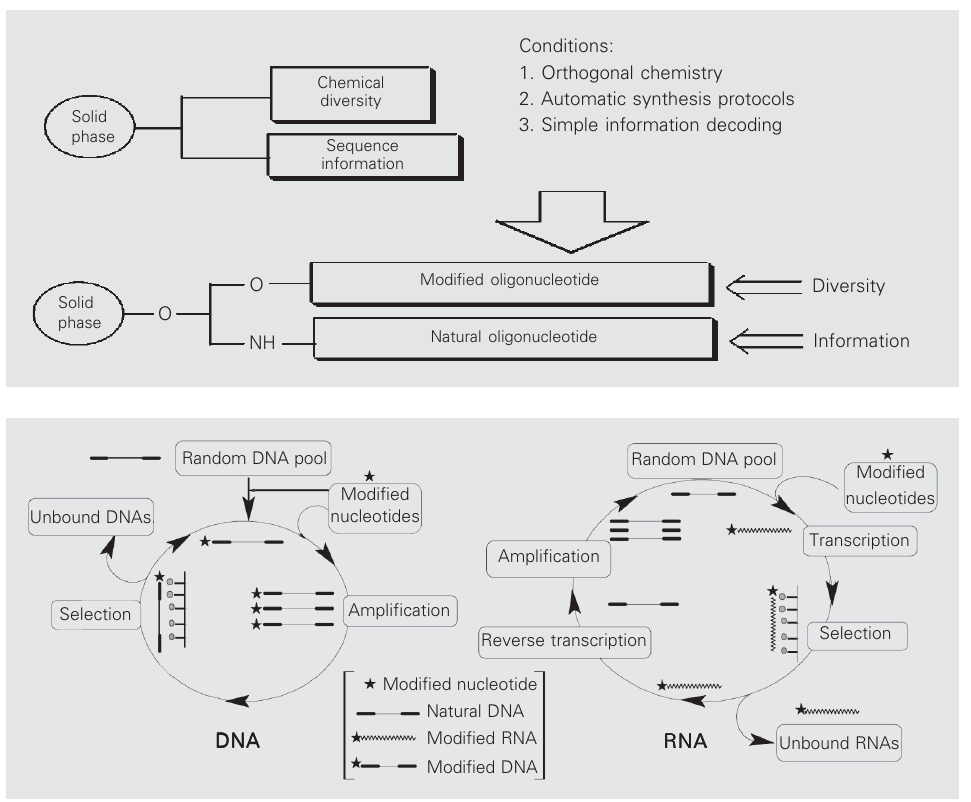
Figure 3. Modified oligonucleo- tide combinatorial libraries.